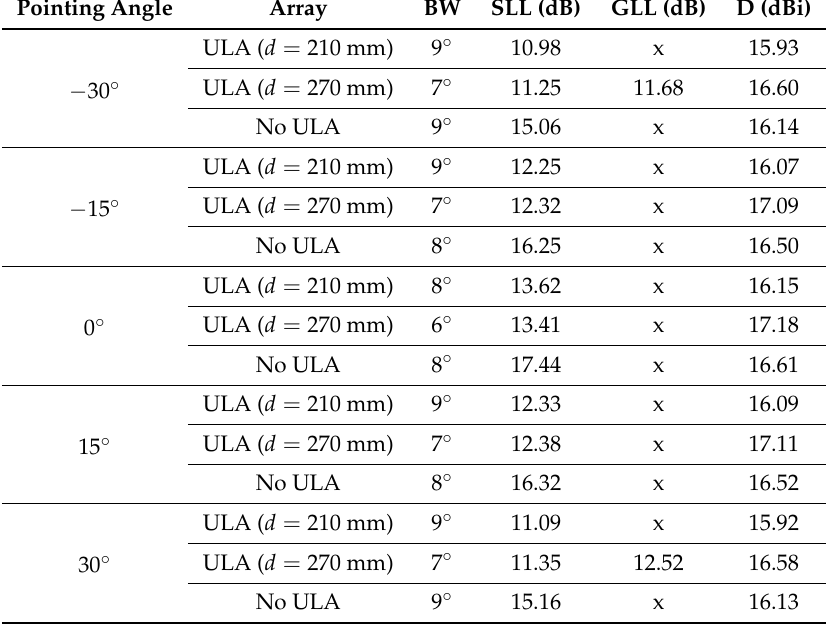
Table 3. Main characteristics of azimuth plane radiation patterns using conventional weighting of the ULAs with inter-element distances of 210 mm and 270 mm and an NULA with N = 11 elements. The considered steering angles are φ = [ − 30 ◦ , − 15 ◦ ,0 ◦ ,15 ◦ ,30 ◦ ] . Pointing